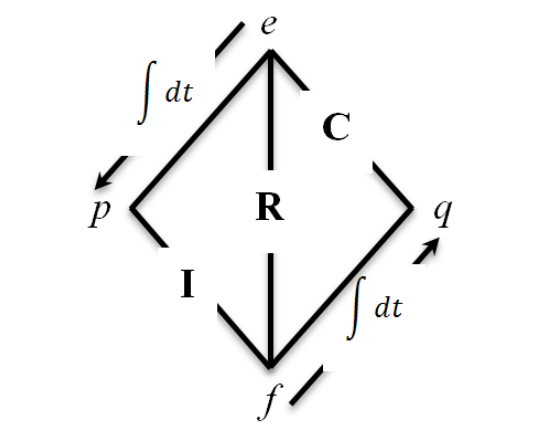
Figure 2: Tetrahedron of state for one-port elements Pedersen and Engja (2001)